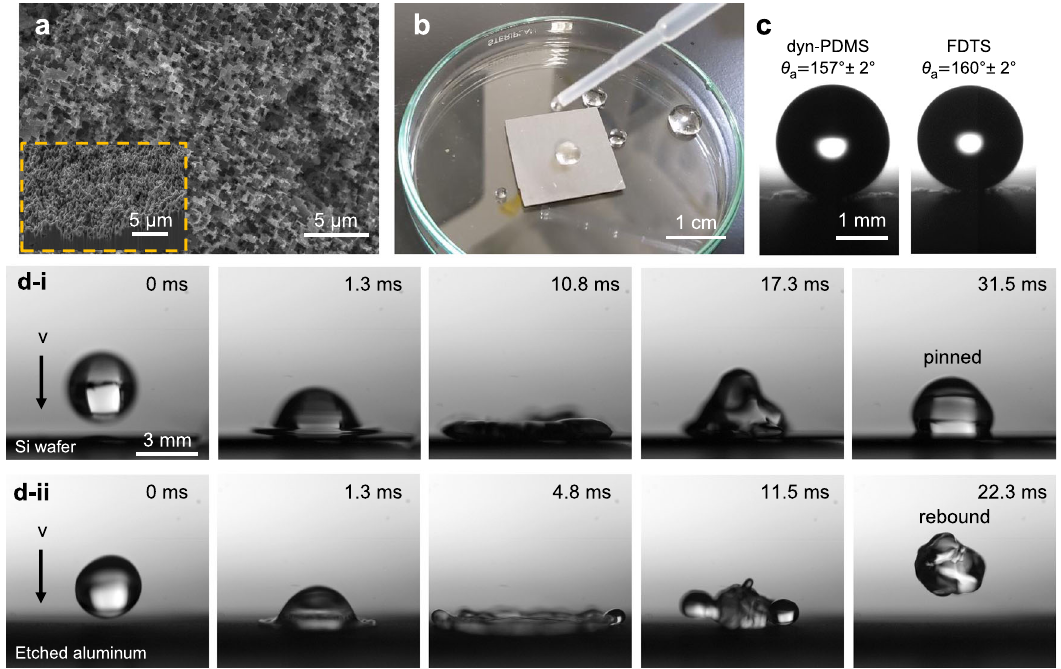
Fig. 4 Superhydrophobicity of dyn-PDMS deposited on etched aluminum substrate. a SEM image of etched aluminum substrate. (inlet: cross-section SEM image). b Photographs of dropping water droplets on 2 cm × 2 cm sized dyn-PDMS coated etched aluminum plate. c Comparison between the wettability of dyn-PDMS and FDTS modi fi ed etched aluminum. d Time-lapse images of water droplet impacting on ( d -i) dyn-PDMS coated silicon wafer and ( d -ii) dyn-PDMS coated etched aluminum. Gravity points downwards in all images showing in c and d